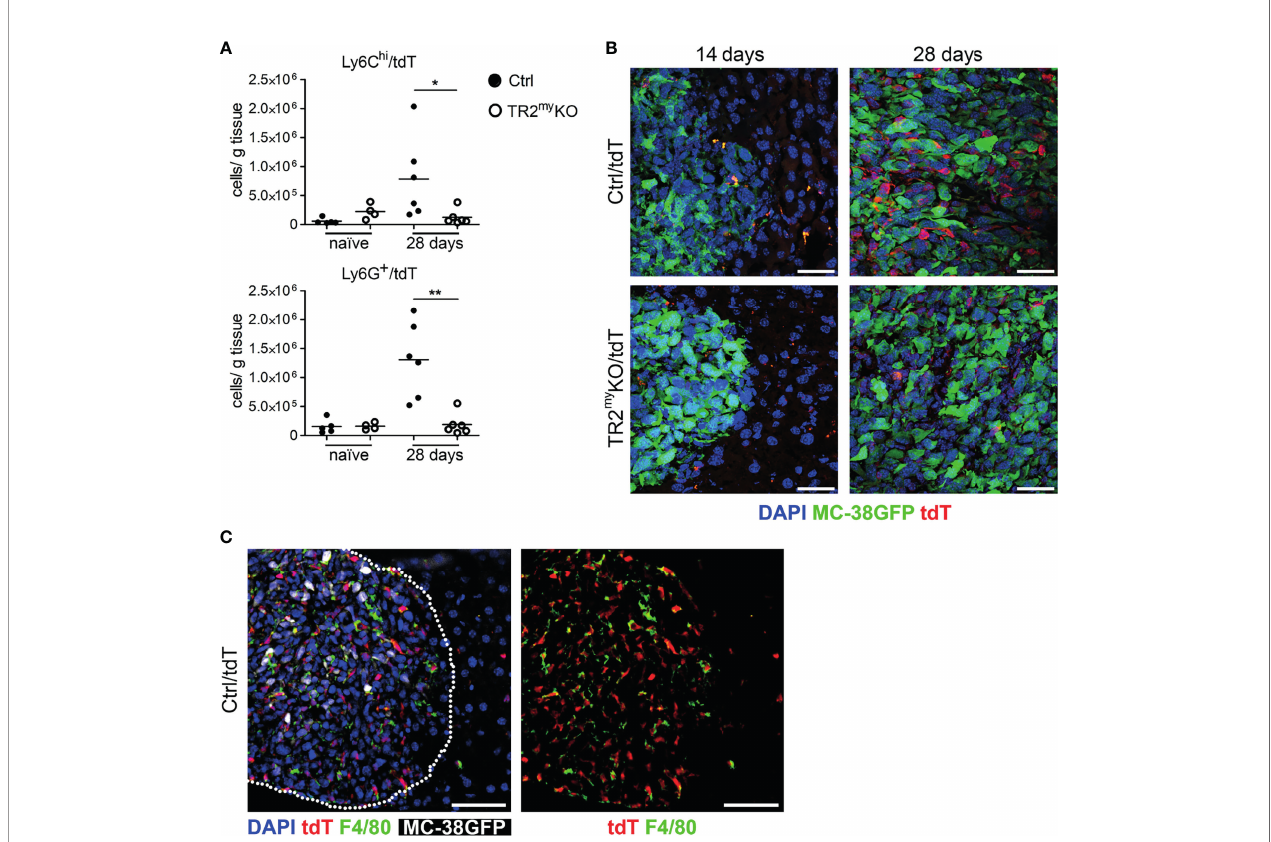
FIGURE 3 | Reduced myeloid cell recruitment to liver metastatic foci in Tgfbr2 -myeloid cell-de fi cient mice. Analysis of tdTomato reporter expression in TR2 my KO (LysMCre + / Tgfbr2 fl / fl /tdT + ) and Ctrl mice (LysMCre + / Tgfbr2 wt /tdT + ). (A) Flow cytometry analysis of tdT-positive Ly6C hi and Ly6G + myeloid cells in perfused livers from TR2 my KO and Ctrl mice at day 28 post-intrasplenic tumor cell injection compared to non-injected mice (naïve). (B) Representative images of metastatic liver foci at day 14 and 28 post-tumor cell injection in TR2 my KO and Ctrl mice showing tumor cells (green), and myeloid cells (red) and counterstained with DAPI (blue). Bar = 30 m m. (C) Immuno fl uorescence analysis of F4/80-stained macrophages in livers 28 days after MC-38GFP splenic injection in Ctrl mice. Dotted line represents the edge of a metastatic focus (left panel); tdTomato channel and F4/80 staining (right panel) Bar = 50 m m. Statistical signi fi cance was assessed using Mann-Whitney test: *p < 0.05; **p <